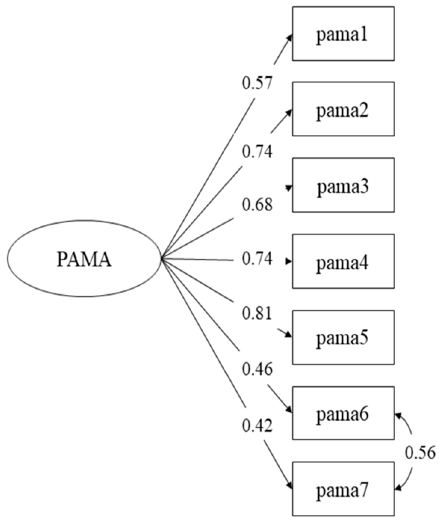
Figure 1. PAMA measurement model with standardized parameters.